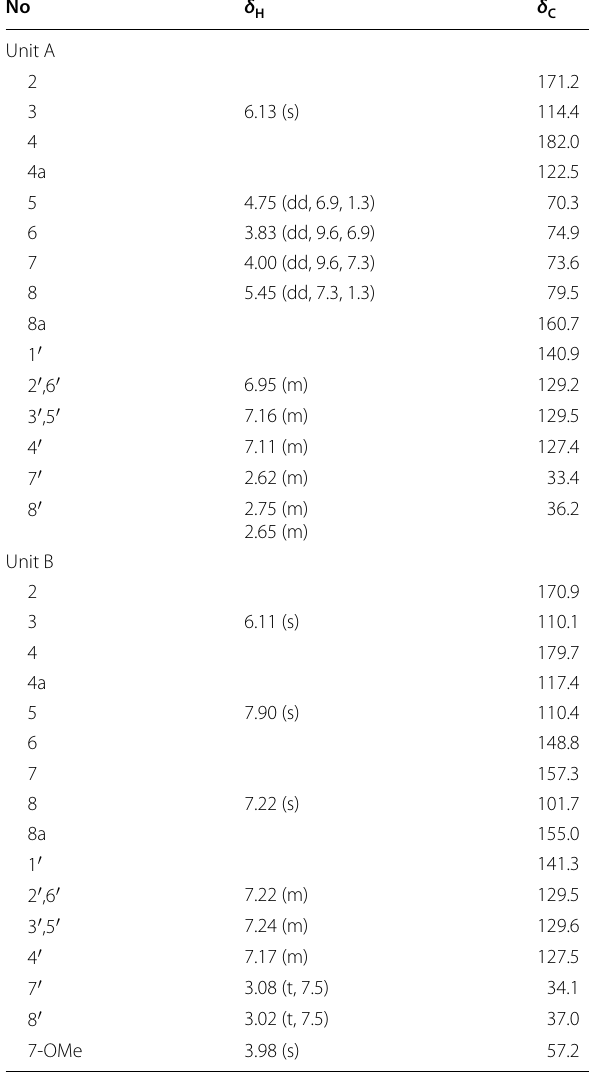
Table 3 1 H (600 MHz) and 13 C (151 MHz) NMR data of 5 in methanol‑ d ( δ in ppm, J in Hz) 4